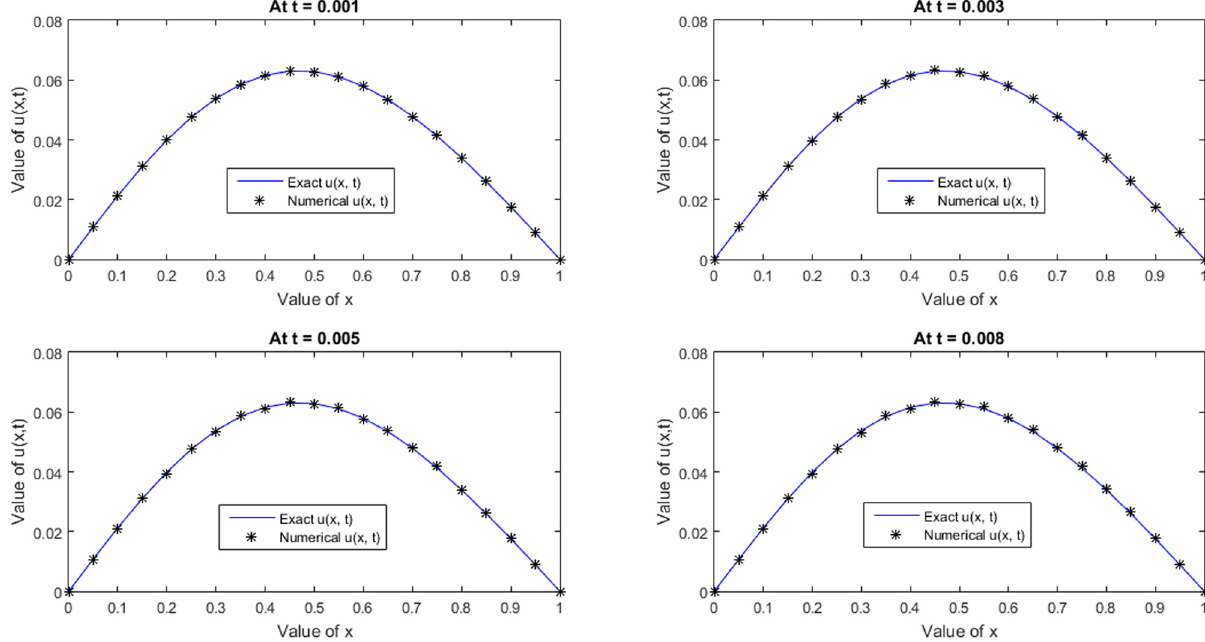
Figure 5: Graphical presentation of solutions for = N 31 , = t 0.0001 , = α 10 , and = ν 0.001